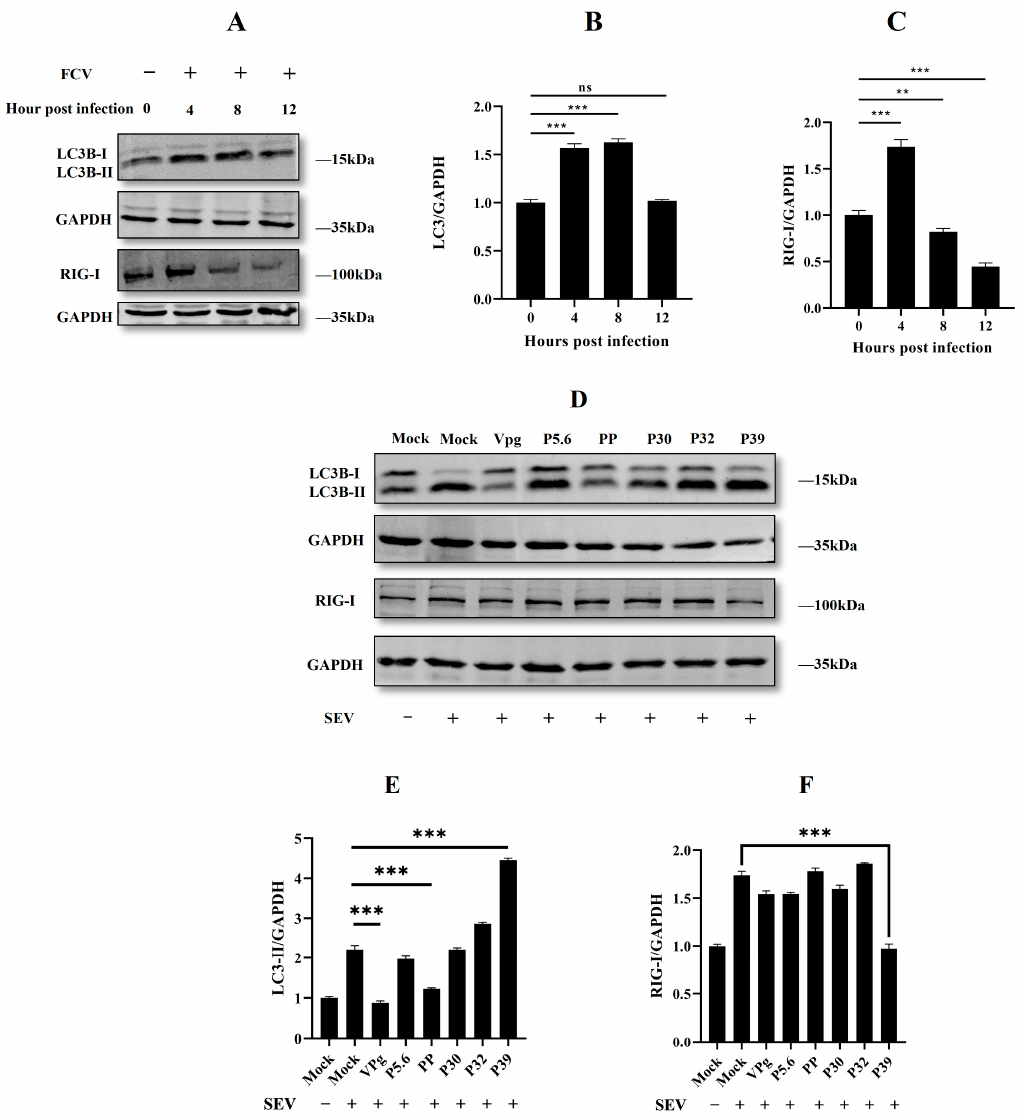
Figure 5. P39 induced autophagy and repressed RIG-I expression. ( A ) CRFK cells were infected with FCV-SCAU-10 at MOI of 1 at 0, 4, 8, and 12 h.p.i. ( B , C ) Protein band intensity of LC3B-II, RIG-I, and GAPDH was used for Western blotting quantification analysis. Samples were analyzed in three independent experiments. ( D ) HEK 293T cells were transfected with different plasmids; 24 h post-transfection, cells were stimulated with SEV. At 12 h post-stimulation, WB analysis was performed. ( E , F ) Protein band intensity of LC3B-II, RIG-II, and GAPDH was used for Western blotting quantification analysis. (ns—not significant, ** p < 0.01, *** p < 0.001).